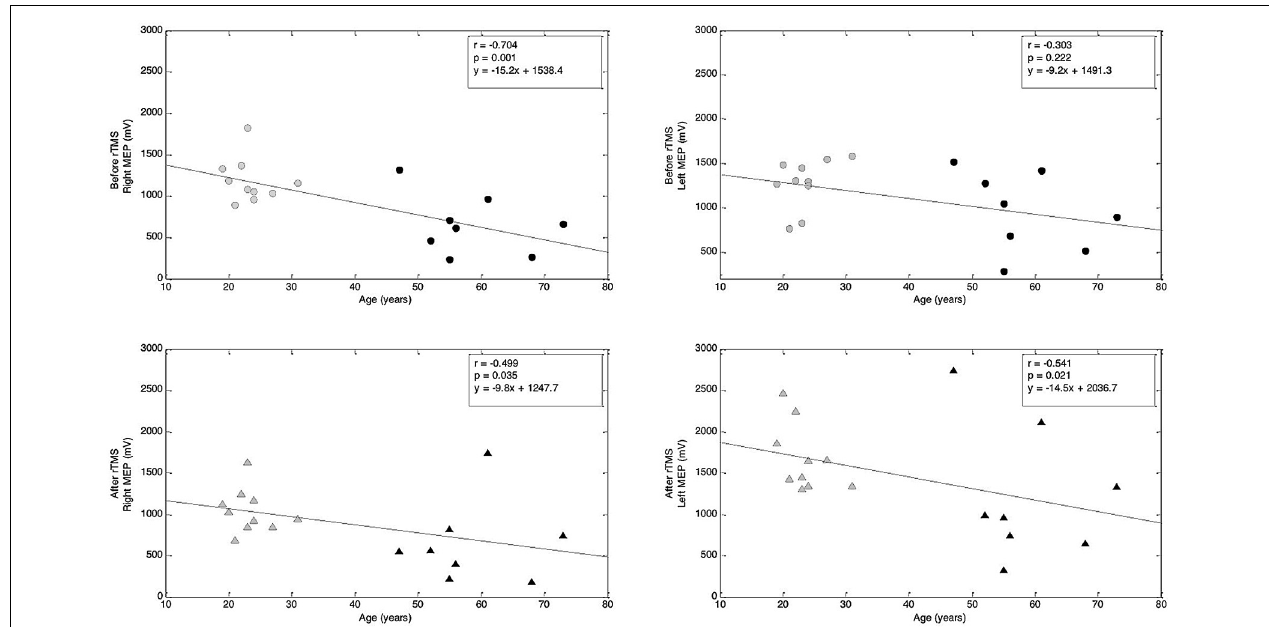
FIGURE 12 | Correlations between age and MEP amplitude before and after rTMS. Top row: Correlation between age and MEP amplitude before rTMS to M1. Bottom row: Correlation between age and MEP amplitude after rTMS to M1. Correlation coefficients